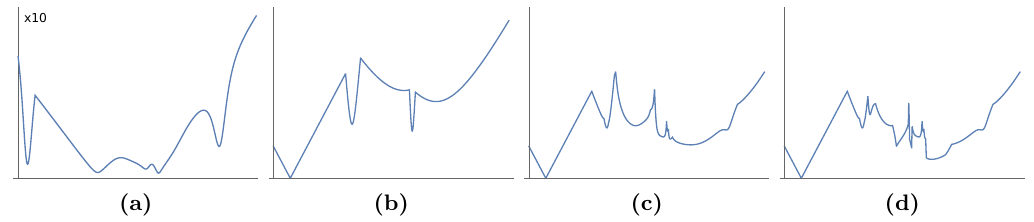
Figure 7. The magnitude of the deformation vector space (see (cid:12)gure 11) is subject to constraints in section 3.3. From left to right: a) no magnitude constraints, b) only continuity constraint enabled, which forces and expansion constraint enabled, d) all constraints enabled, i.e. continuity, expansion and complex pole constraint. The scale of a) is ten times larger than the scale of the other plots, since we use a non-restrictive (cid:21) max = 10. The image is scaled down for